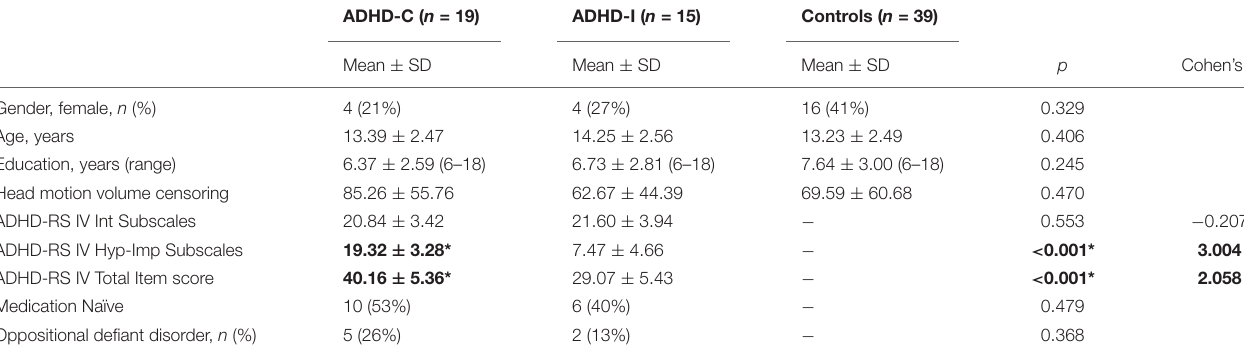
TABLE 1 | Participant demographic and clinical